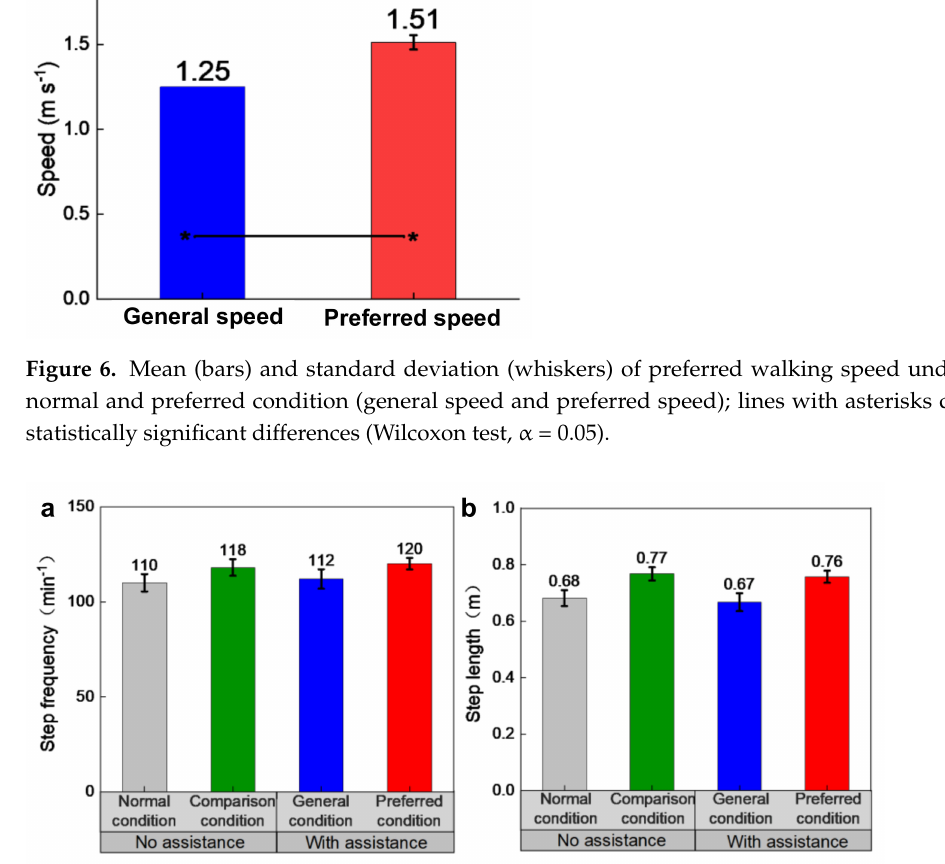
Figure 7. Preferred step frequency and step length under different conditions; ( a ) mean (bars) and standard deviation (whiskers) of step frequency under the normal condition (light grey bars), general condition (blue bars), preferred condition (red bars) and comparison condition (green bars); ( b ) mean (bars) and standard deviation (whiskers) of step length under the normal condition (light grey bars), general condition (blue bars), preferred condition (red bars) and comparison condition (green